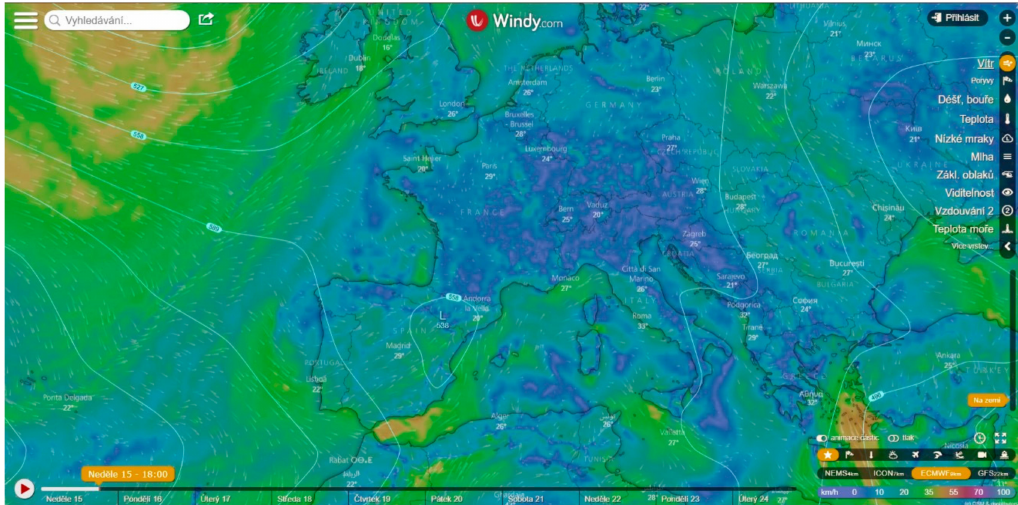
Figure 2. Windy map preview. The map has a composition divided into logical elements (search, timeline, display options, information menu). The sample map in the preview is presenting